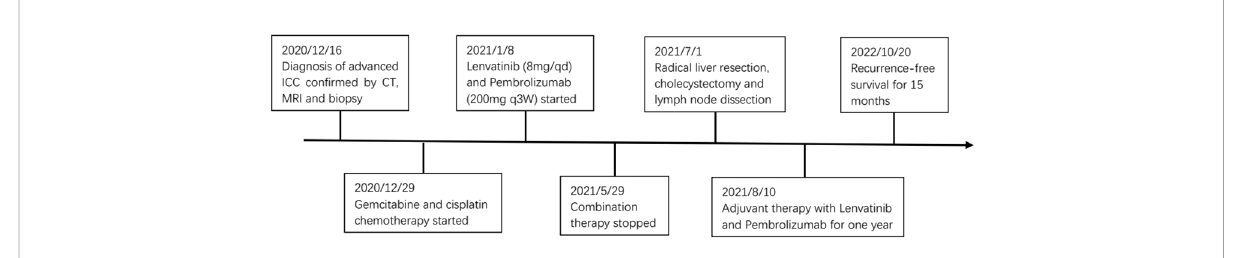
FIGURE 4 Timeline of initial diagnosis, combination therapy, radical surgery, adjuvant therapy and